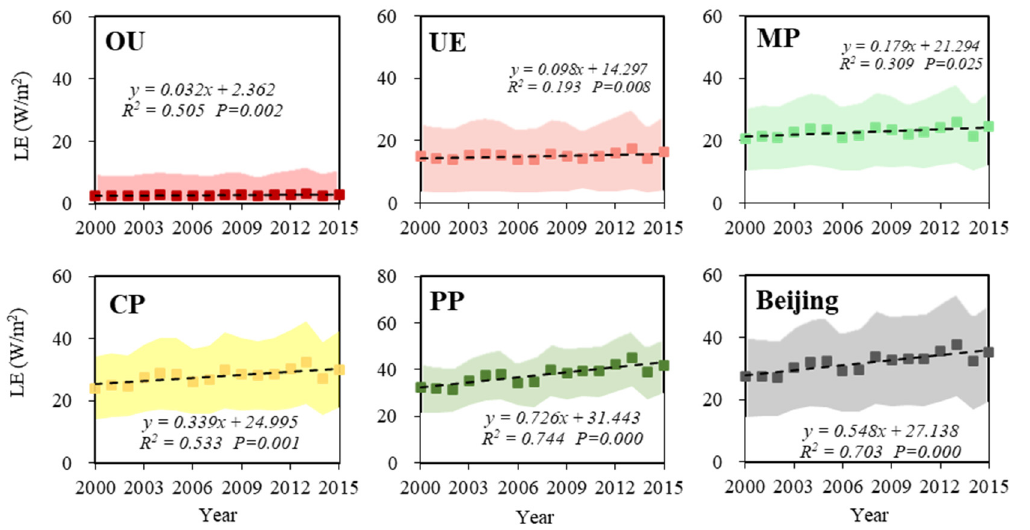
Figure 7. Variation trends of latent heat flux (LE) under various land use types in Beijing from 2000 to 2015.